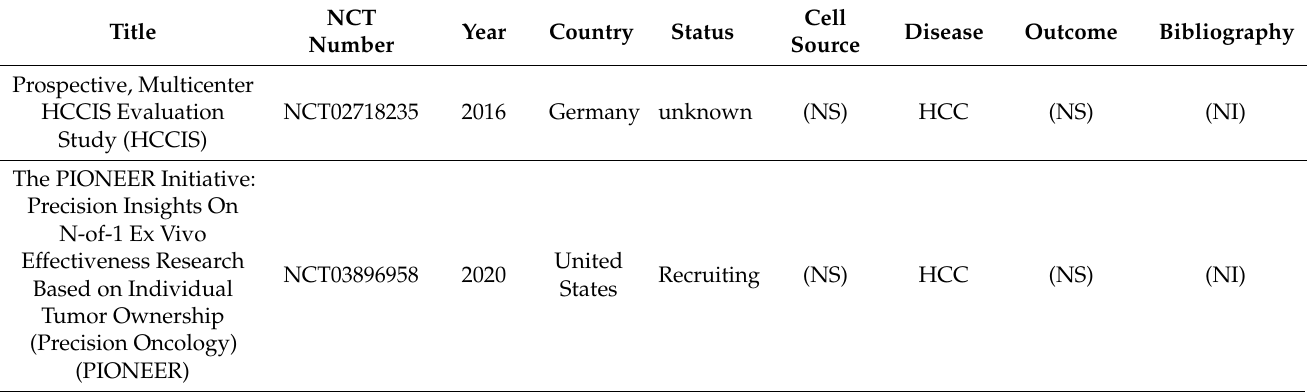
Table 2. Clinical Trials Based on the Use of Organoids for Liver